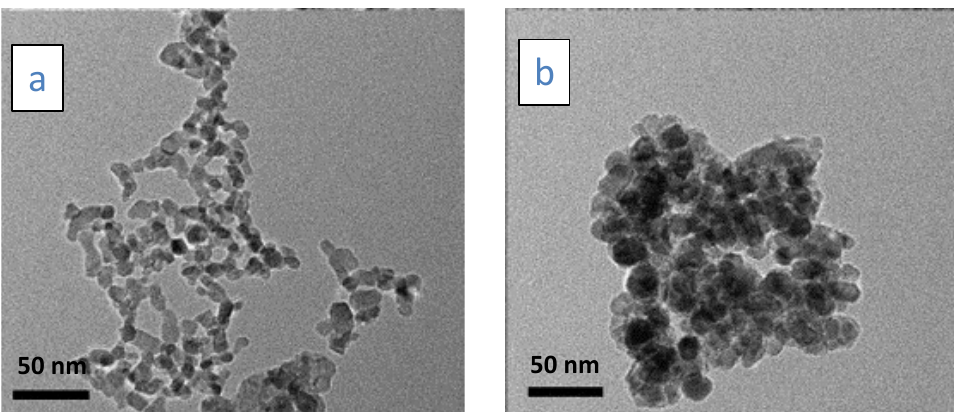
Figure 7. Transmission electron microscopy (TEM) images of aerogel ( a ) and xerogel ( b ) TiO 2 samples calcined at 400 °C. (Adapted with permission from [77]. Copyright Elsevier, 2006).